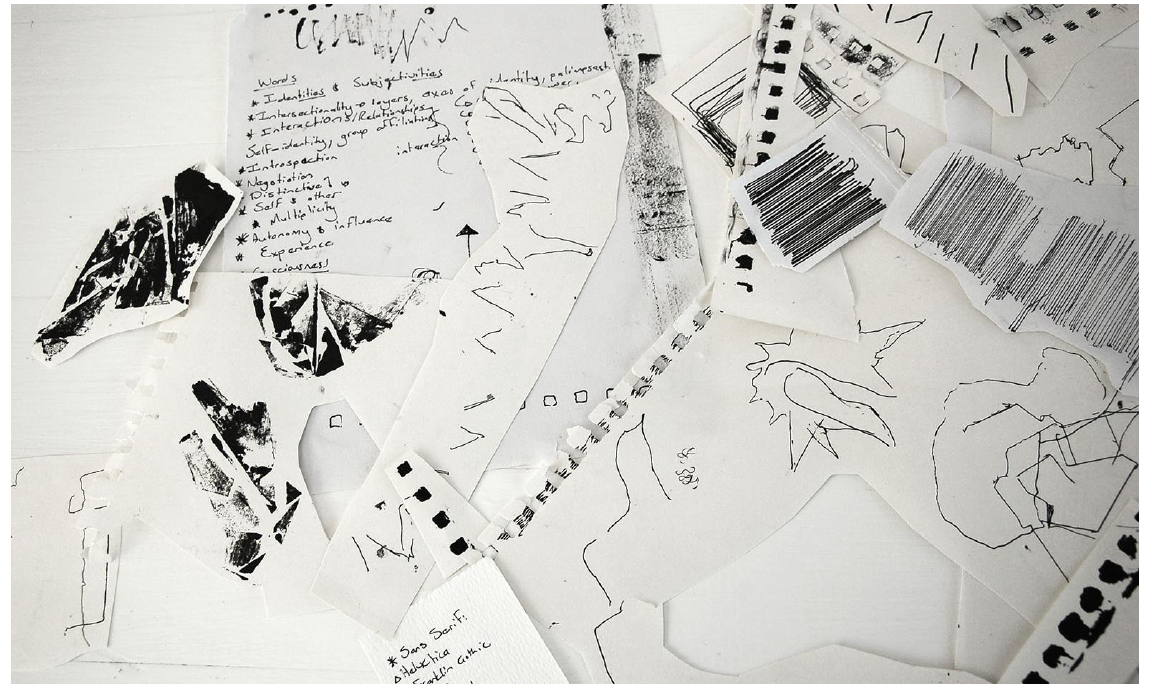
Figure 2.1 : Project 2: Process development (directed visual exploration and mark making exercises) (Source: Emma, 2015)